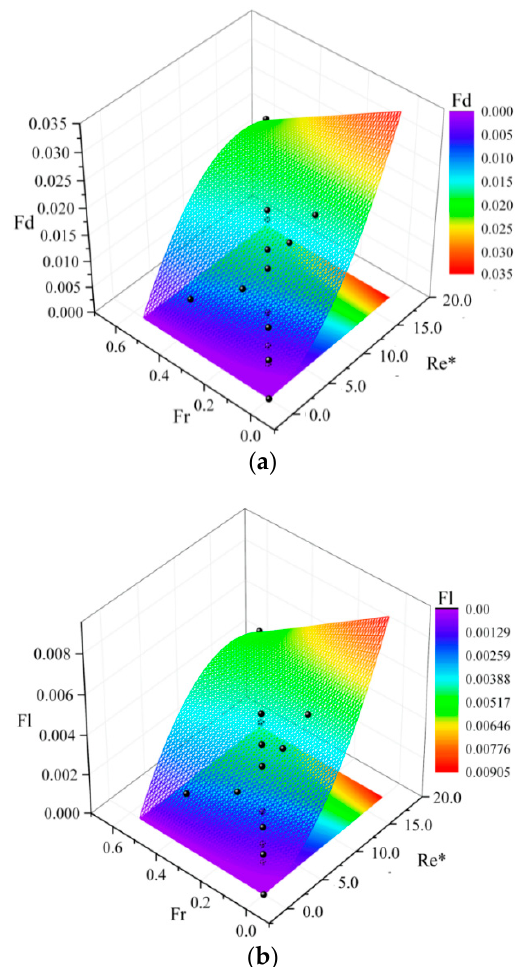
Figure 22. Computed hydrodynamic force. ( a ) The coefficient of drag force. ( b ) The coefficient of lift force. Spheres-computed hydrodynamic forces, surfaces, Equations (12) and (13).